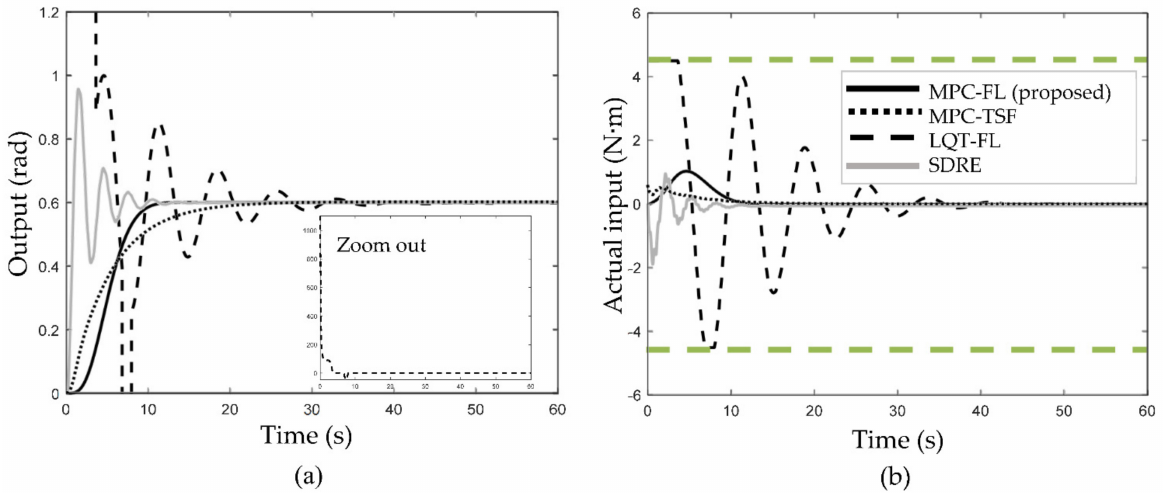
Figure 4. Flexible-joint mechanism by applying the four control schemes with input constraints ± 4.5 N · m: ( a ) output responses; ( b ) input signals.